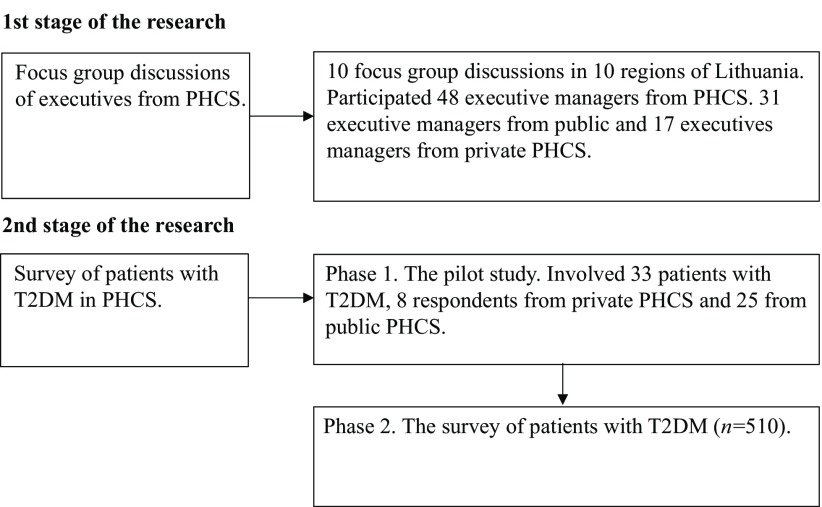
The research design